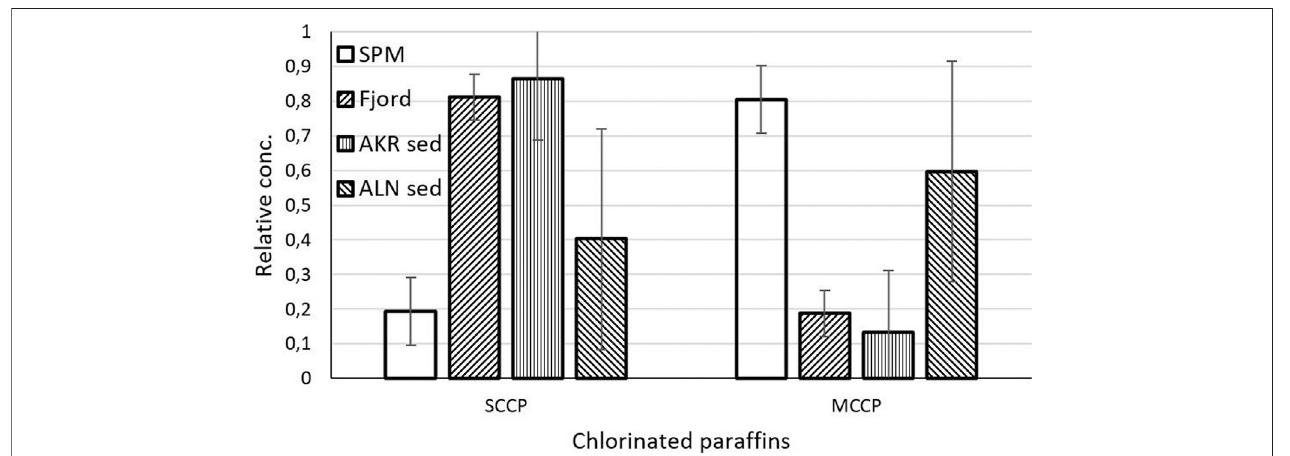
FIGURE 7 | Pro fi les of chlorinated paraf fi ns, expressed as the fraction of SCCP and MCCP as part of the total CPF, quanti fi ed in the SPM samples (2010/2011, n (cid:1) 6) compared to sediment samples in the Oslo fjord (2004, n (cid:1) 5; Arp and Breedveld, 2009), Aker River (Stations Ak, n (cid:1) 5; Ranneklev et al., 2009) and Alna River (Stations Aln, n (cid:1) 7; Ranneklev et al., 2009).